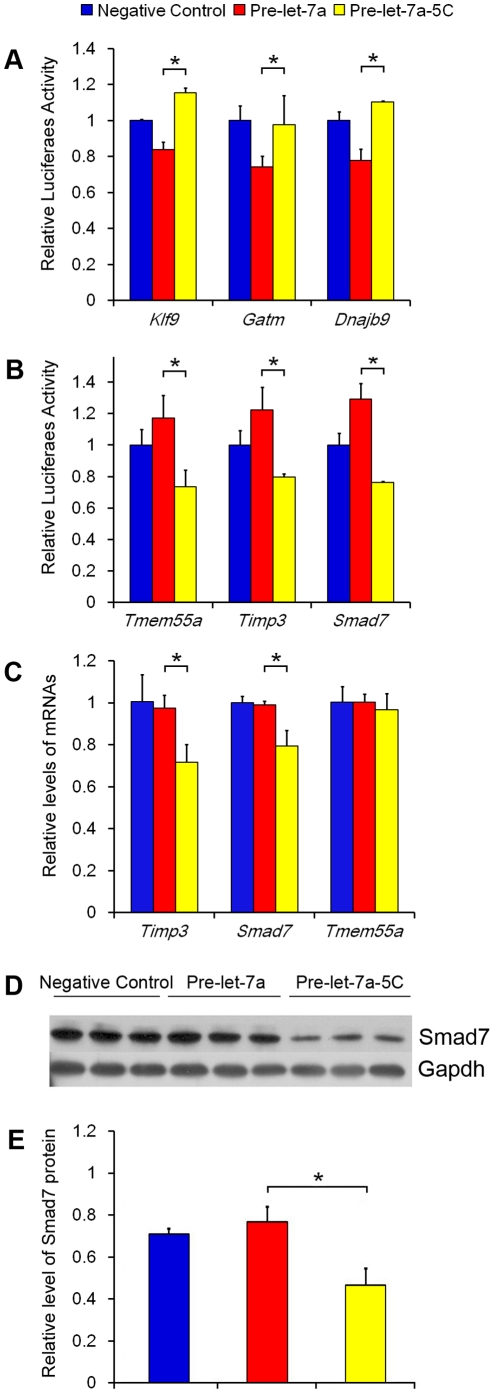
Prediction and confirmation of the target genes predicted for both let-7a (unedited) and let-7a-5C (edited).(A) The confirmation of the target genes (Klf9, Gatm and Dnajb9) of let-7a in mouse 3T3 cells using dual-luciferase assay. Cells were co-transfected with negative control, let-7a (Pre-let-7a) or let-7a-5C (Pre-let-7a-5C) precursor, respectively; (B) The confirmation of the target genes (Tmem55a, Timp3 and Smad7) of let-7a-5C in mouse 3T3 cells; (C) The relative mRNA expression level of the three target genes of edited let-7a-5C in cultured mouse stromal cells transfected with negative control, Pre-let-7a or Pre-let-7a-5C; (D) Protein level of Smad7 was detected by Western blot after mouse stromal cells were transfected with negative control, Pre-let-7a or Pre-let-7a-5C; (E) Quantification of Smad7 protein expression in (D). The difference between Pre-let-7a and Pre-let-7a-5C was compared using t-test, and the significant difference between two groups was labeled with asterisk.